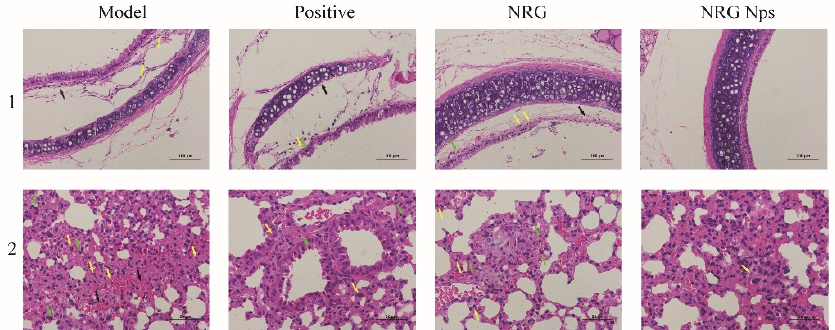
Figure 6. HE staining images of blank model, positive drug, NRG, and NRG NPs groups: trachea tissue (line 1), lung tissue images (line 2).